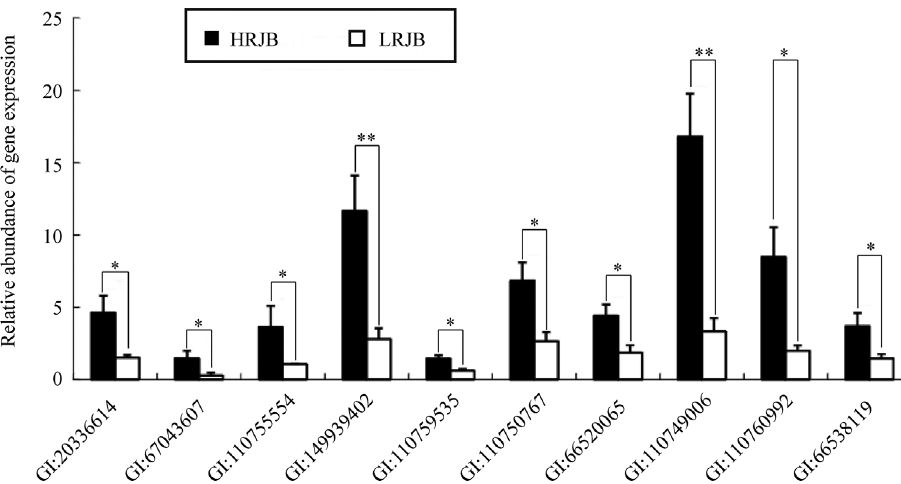
Figure 4 - Validation of the differential expression of ten genes in high royal jelly producing bees (HRJB) and low royal jelly producing bees (LRJB) by qRT-PCR analysis. Four colonies of HRJB with a high royal jelly production and four colonies of LRJB with a low royal jelly production were selected from the back-cross progeny colonies, of which heads of nursing bees (n = 30) were collected per colony were used as materials for qRT-PCR analyses. Independent-sample t -tests were performed to analyse the results using the SPSS 13.0 software. * p < 0.05; ** p <